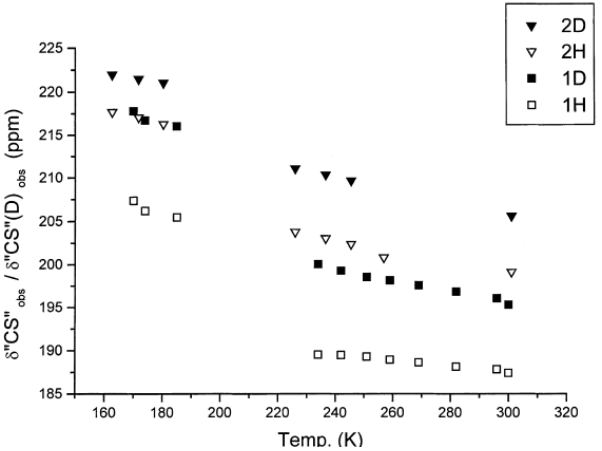
Figure 9. Plot of “CS” chemical shift vs. temperature. Taken from Ref. [82] with permission from Elsevier.